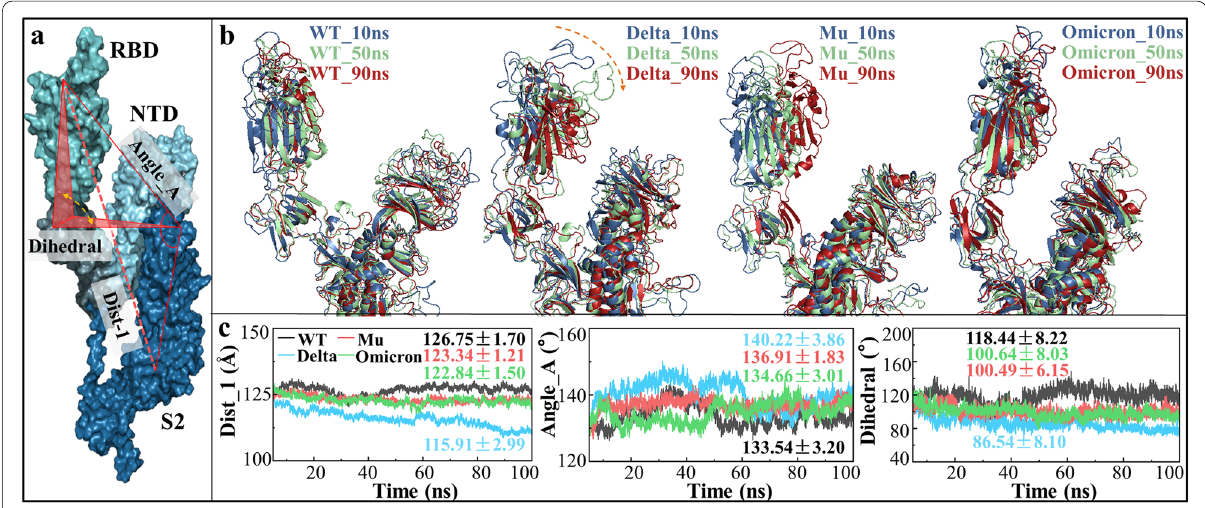
Fig. 5 The up and down conformations of RBD. a Three parameters are used to describe the relative position of RBD and S2 in SP: the distance ( Dist_1 ) between Q493-L1034 Ca atoms, the angle ( Angle_A ) among Q493-K986-L1034 Ca atoms, the dihedral angle ( Dihedral ) among Q493-F543-V576-K986 Ca atoms; b structural superimposition from the snapshots at 10, 50 and 90 ns in the four systems; c the changes of the three parameters over